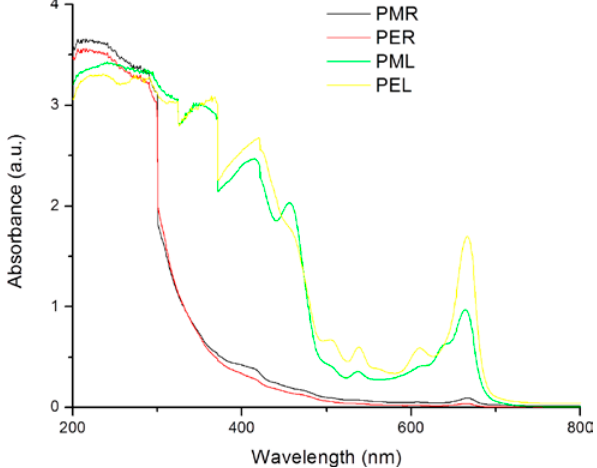
Fig. 2. UV-Vis spectra of the ethanol and methanol extracts of Poly- stichum setiferum (Forssk.) Moore ex Woyn.